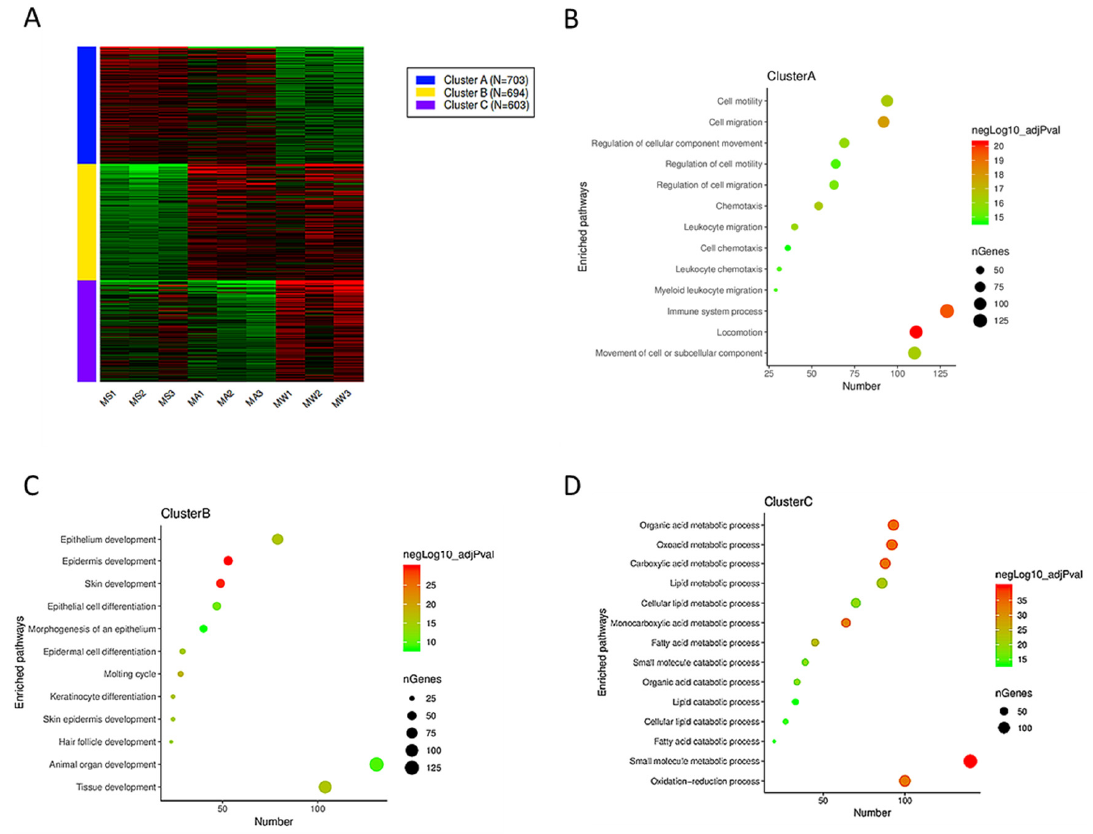
Figure 5. Pathway enrichment of activated genes in the autumn group. ( A ) K-means hierarchical clustering; ( B–D ) pathway enrichment in three clusters.